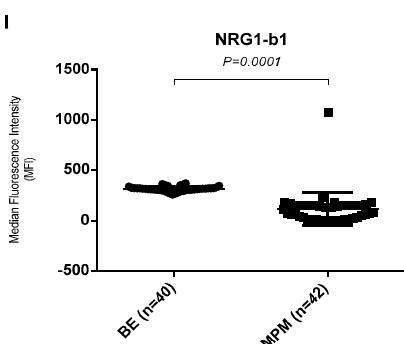
Figure 2. Biomarker levels in pleural e ff usion of malignant pleural mesothelioma (MPM) patients compared to benign e ff usions (BE). ( A – H ) Levels of Galectin-1, Mesothelin, Osteopontin, shed SDC-1, Figure 2 . Biomarker levels in pleural effusion of malignant pleural mesothelioma (MPM) patients VEGF, MMP-7, HGF and TIMP-1 are significantly higher in pleural e ff usion from malignant pleural compared to benign effusions (BE). ( A – H ): Levels of Galectin-1, Mesothelin, Osteopontin, shed SDC-1, VEGF, MMP-7, HGF and TIMP-1 are significantly higher in pleural effusion from malignant pleural mesothelioma (MPM) patients ( n = 42) comparing with benign (BE) patients ( n = 40). ( I ). Level of NRG1- β 1 is significantly lower Significance was assessed by two-tailed t -test at p ≤ 0.05.